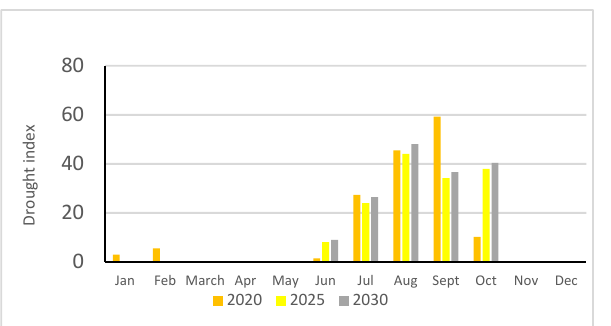
Figure 12. Change of the Drought Index in the years 2020, 2025, and 2030 based on the simulation with scenario two in the Dodokan Watershed.